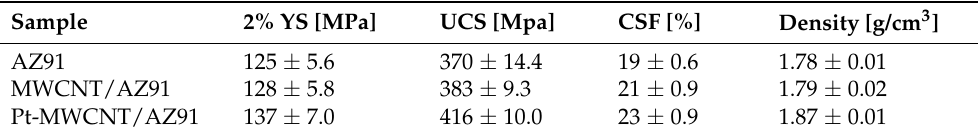
Table 1. Experimental values of yield strength (YS), ultimate compressive strength (UCS), compres- sion strain at failure (CSF), and density of pure AZ91, 0.05 wt% MWCNT/AZ91, and 0.05 wt% Pt-coated MWCNT/AZ91.